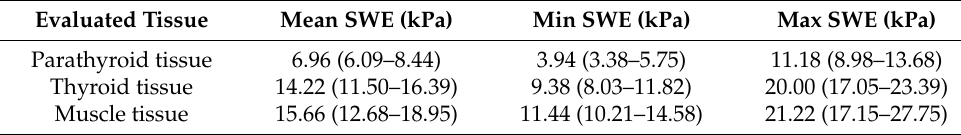
Table 4. Results of the second lot of secondary hyperparathyroidism.